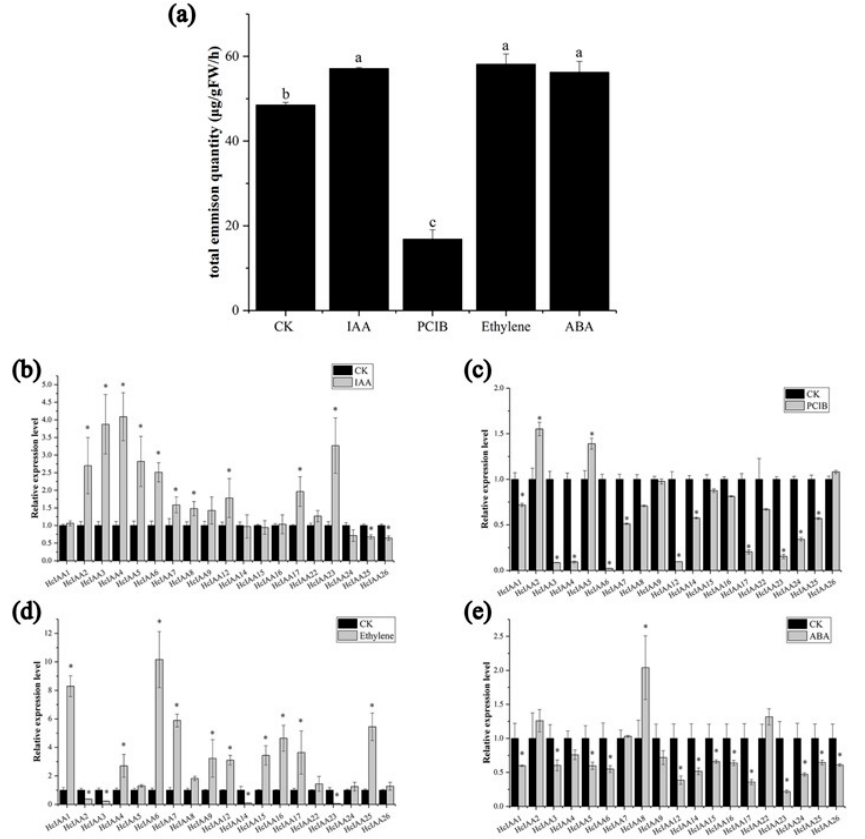
Figure 7. Relative expression levels of HcIAA genes and emission of floral volatiles under di ff erent hormonal treatments. ( a ) The amount of floral volatiles during di ff erent treatment. The expression of HcIAA genes in response to ( b ) IAA, ( c ) PCIB, ( d ) ethylene and ( e ) ABA treatments was analyzed by qRT-PCR. The expression levels of HcIAA genes in control flowers were set to a value of 1. The expression levels of HcIAA genes in IAA (100 µ M), PCIB (1.5 mM), ethylene (10 µ L / L) and ABA (200 µ M) treated flowers were compared to a mock treatment for relative mRNA levels. Error bars represent standard deviations from three biological replicates. Significant di ff erences (* p < 0.05) between the hormone-treated samples and control are indicated by an asterisk.